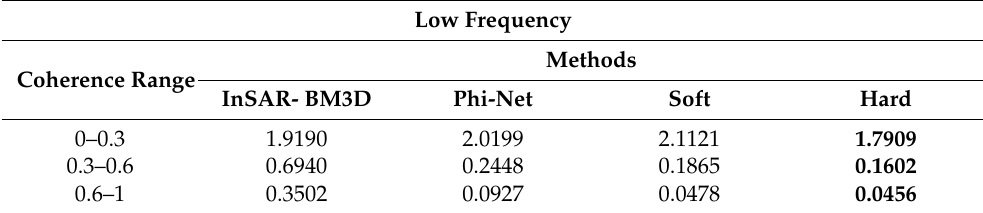
Table 3. Quantitative index Equation (36) of the compared methods on simulated low-frequency fringes.